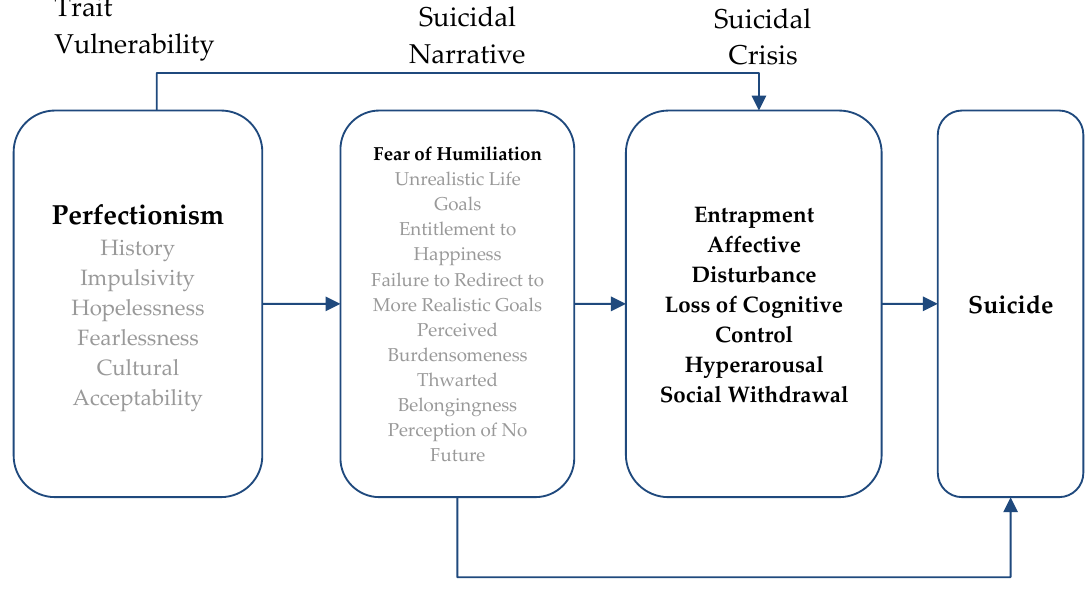
Figure 1. The Narrative-Crisis Model of suicide.